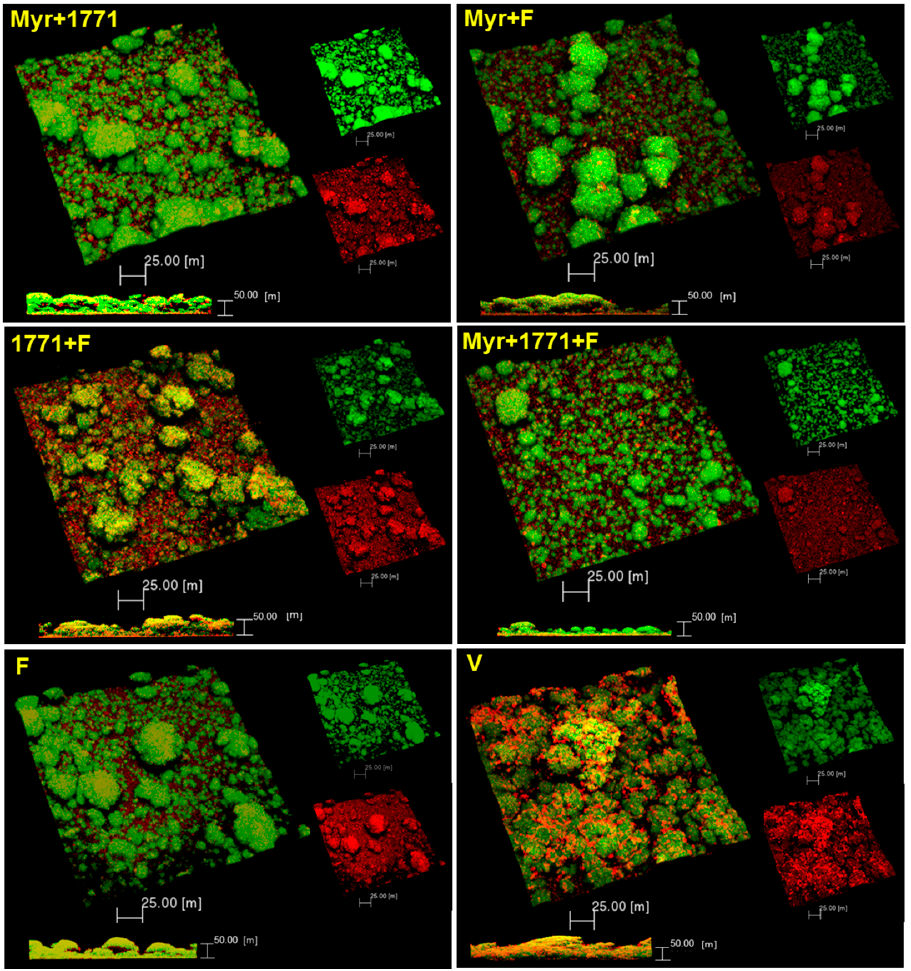
Figure 7. 3D architecture of the topically treated S. mutans biofilm. Representative images of 67 h-old biofilms are displayed in this image. The red color represents exopolysaccharides produced by S. mutans (Alexa Fluor 647) and the green color S. mutans cells (SYTO 9). The larger image in each set represents the overlapping images of the red and green channels, which are shown separately in a smaller size (scale bars of 25 µm). The bottom images are a cross-section of the biofilm with overlapping images of both channels (scale bars of 50 µm). Molecules 2020 , 25 , x FOR PEER REVIEW